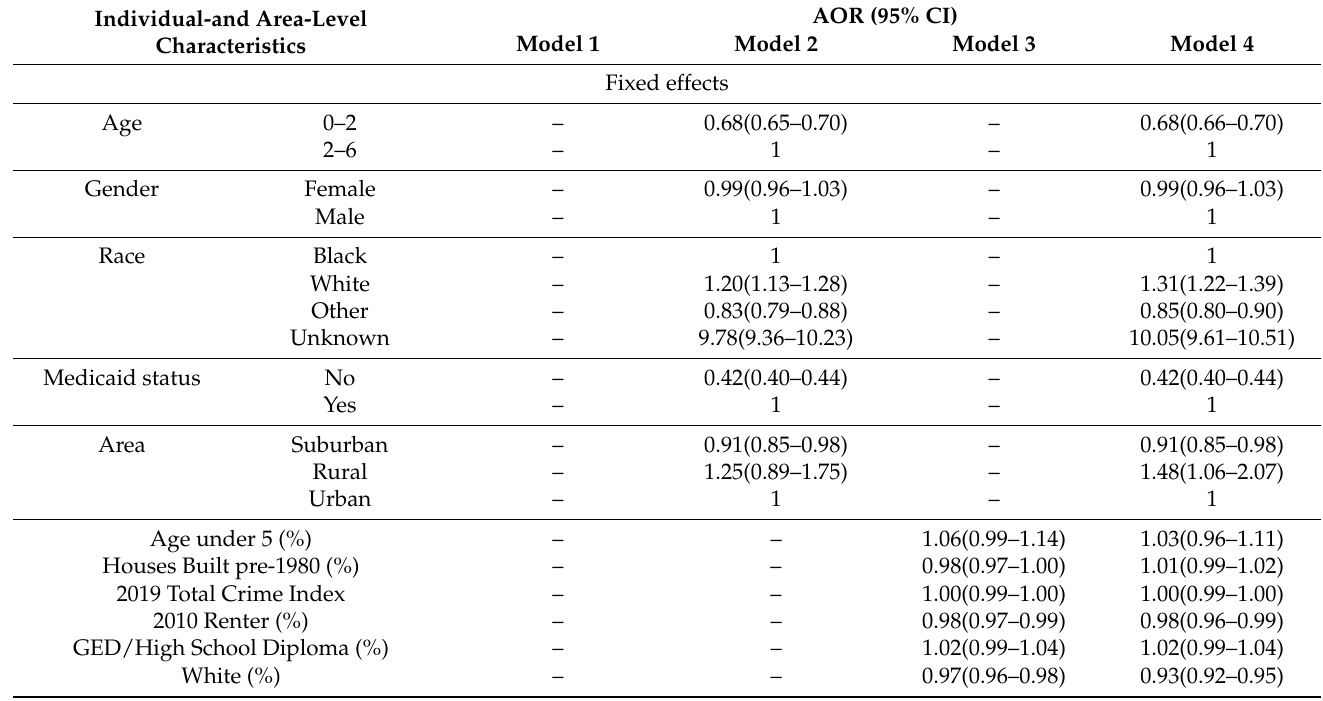
Table 3. Individual and area-level predictors of the likelihood of having a BLL 2 to <5 µ g/dL, compared to BLL < 2 µ g/dL in 93,162 children aged 0–72 months living in 20 counties in or near the Atlanta Metropolitan Statistics area who had a valid venous blood lead test in the years